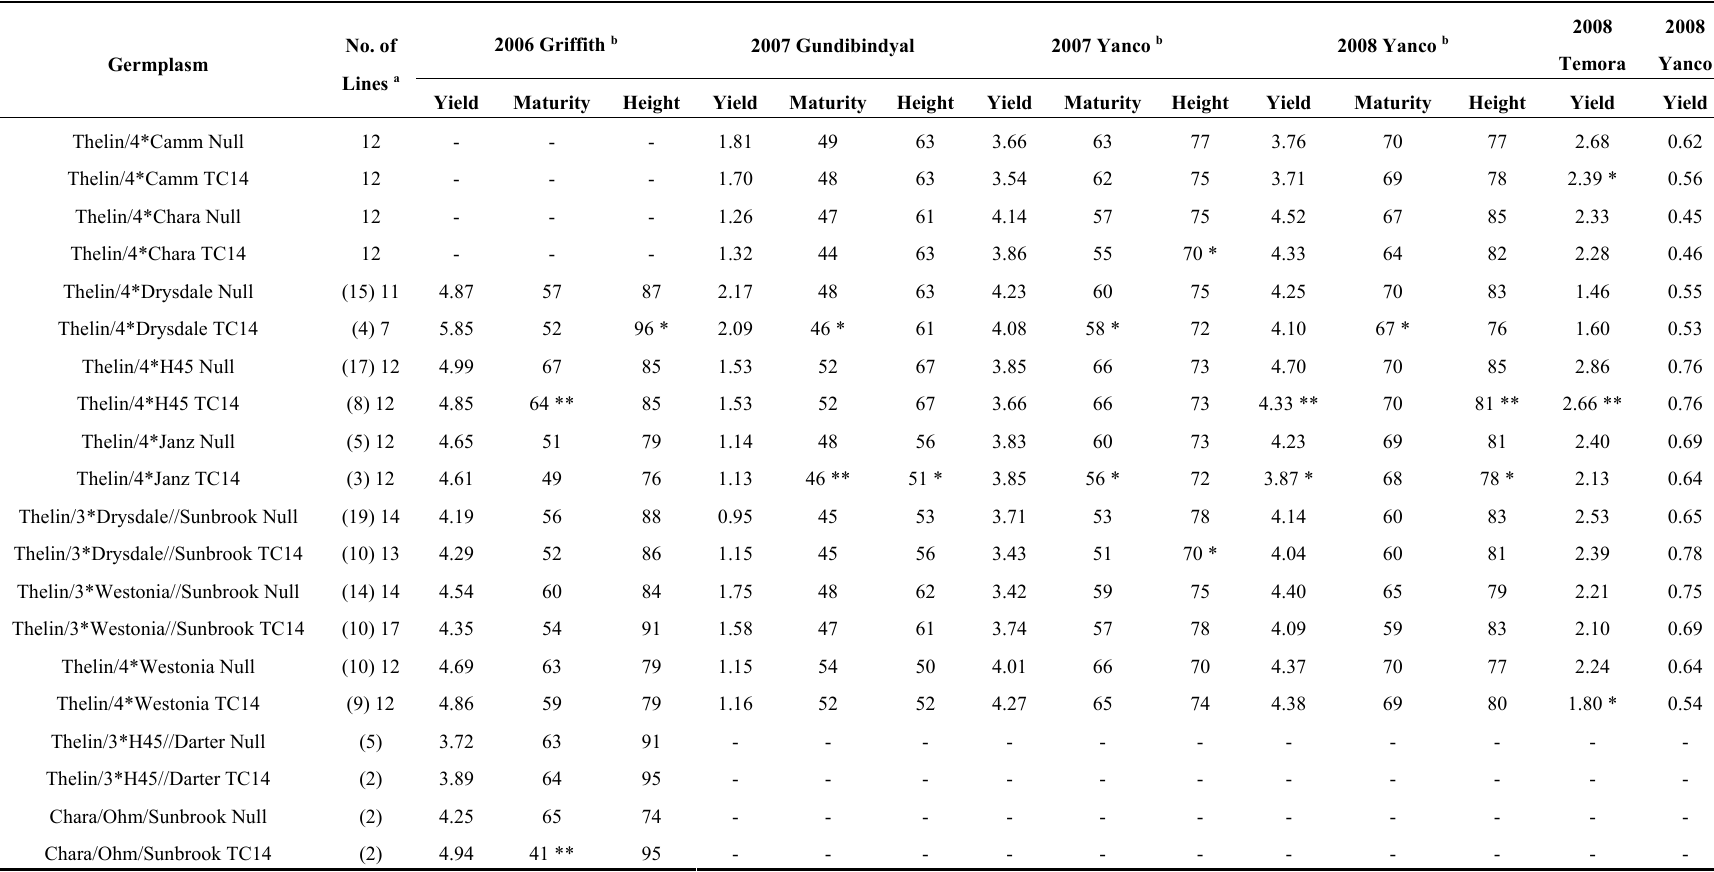
Table 5. Association of the TC14 lines with changes in yield, maturity [14] and height in different genetic backgrounds.